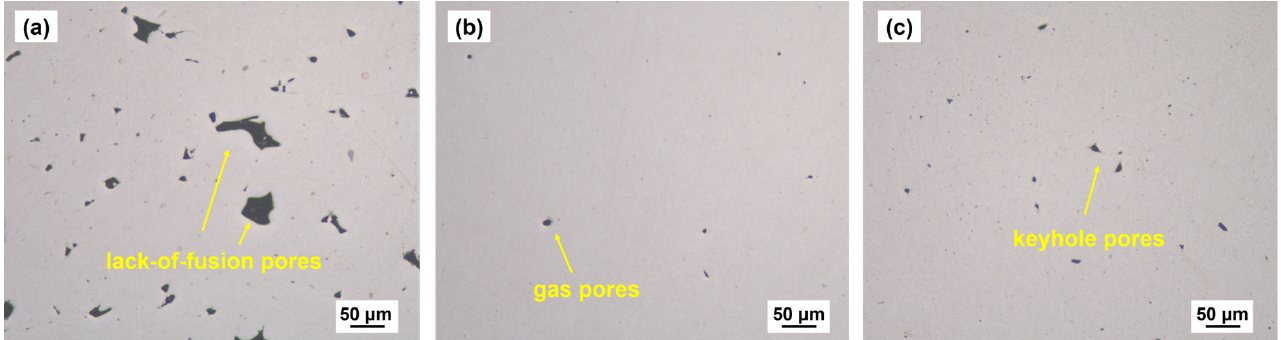
Figure 5. The typical morphologies of the three main classifications of pores. ( a ) is lack-of-fusion pores, ( b ) is gas pores, ( c ) is keyhole pores.